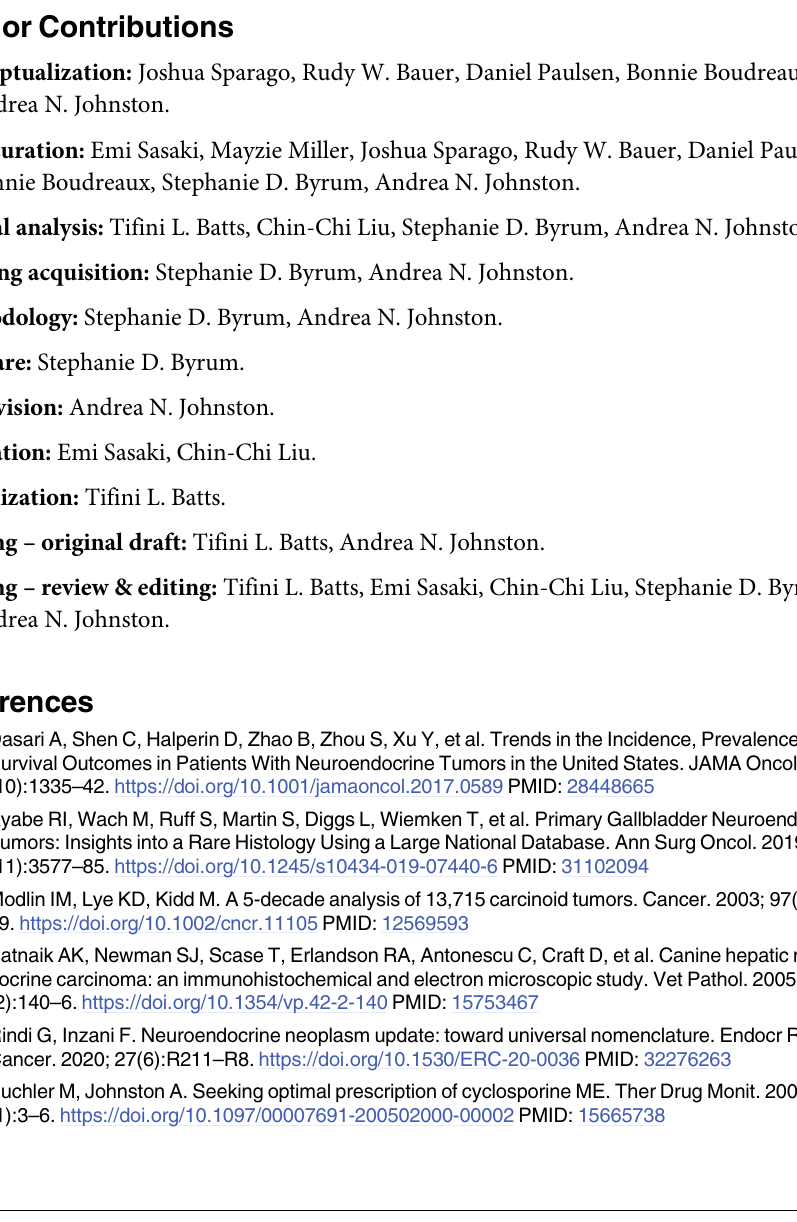
S2 Fig. Galectin-1 immunofluorescent staining. Nuclei are labeled by Hoescht stain (blue, left panels). Gall bladder neuroendocrine neoplasm demonstrates positive galectin-1 (red, middle and right top panels) immunofluorescence compared to negative control (normal canine kidney). Scale bars: 10